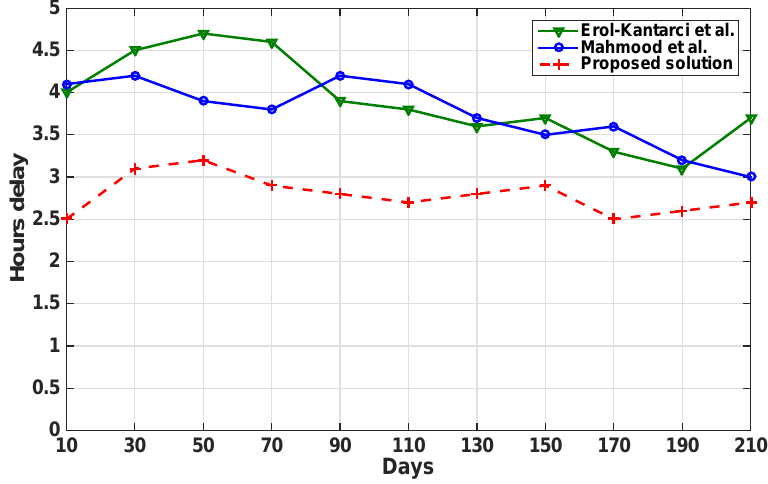
Figure 9. Average delay experienced by the consumer in HEM